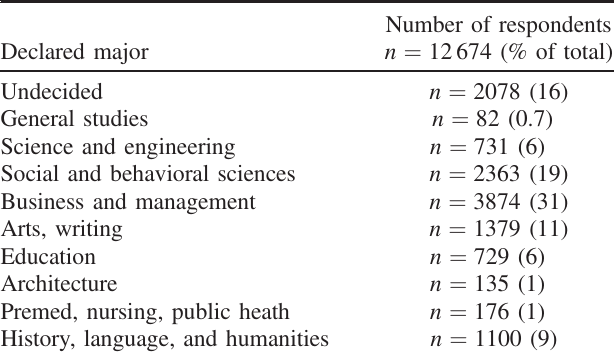
TABLE IV. Students ’ self-reported